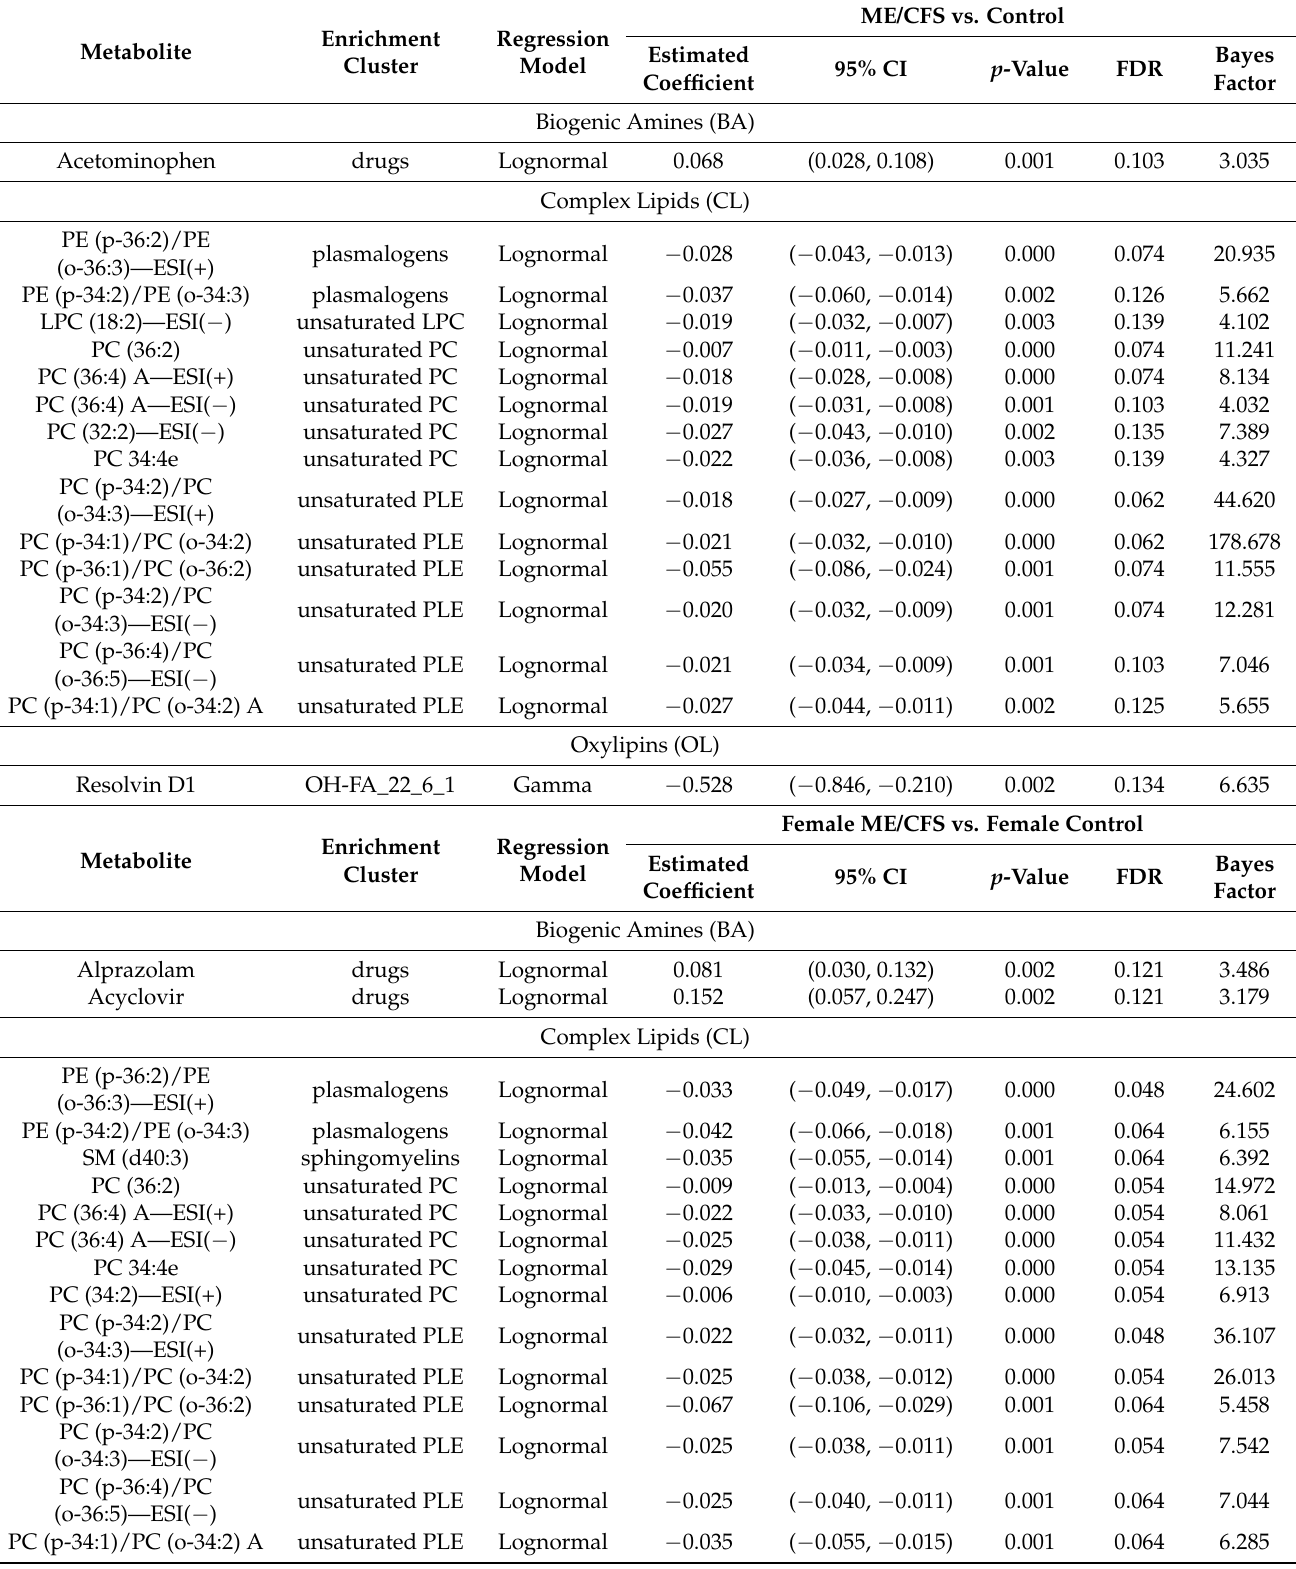
Table 2. Metabolites significantly associated with ME/CFS or ME/CFS